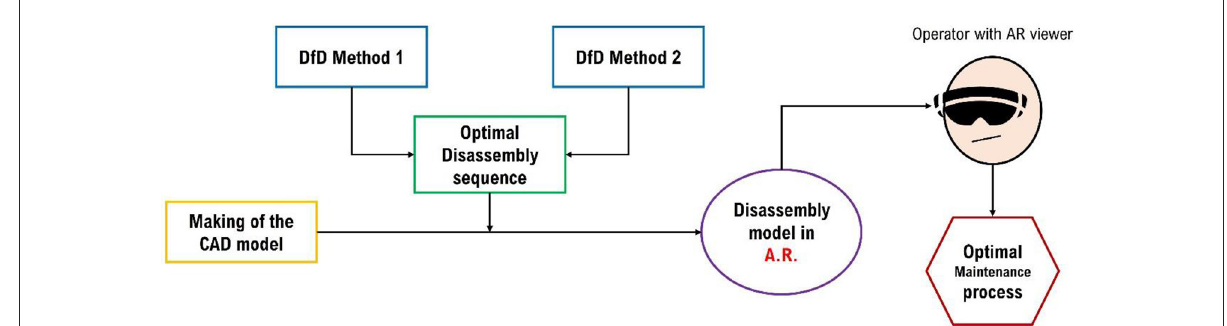
FIGURE1 Workflow concerning DfD and AR for the maintenance process.